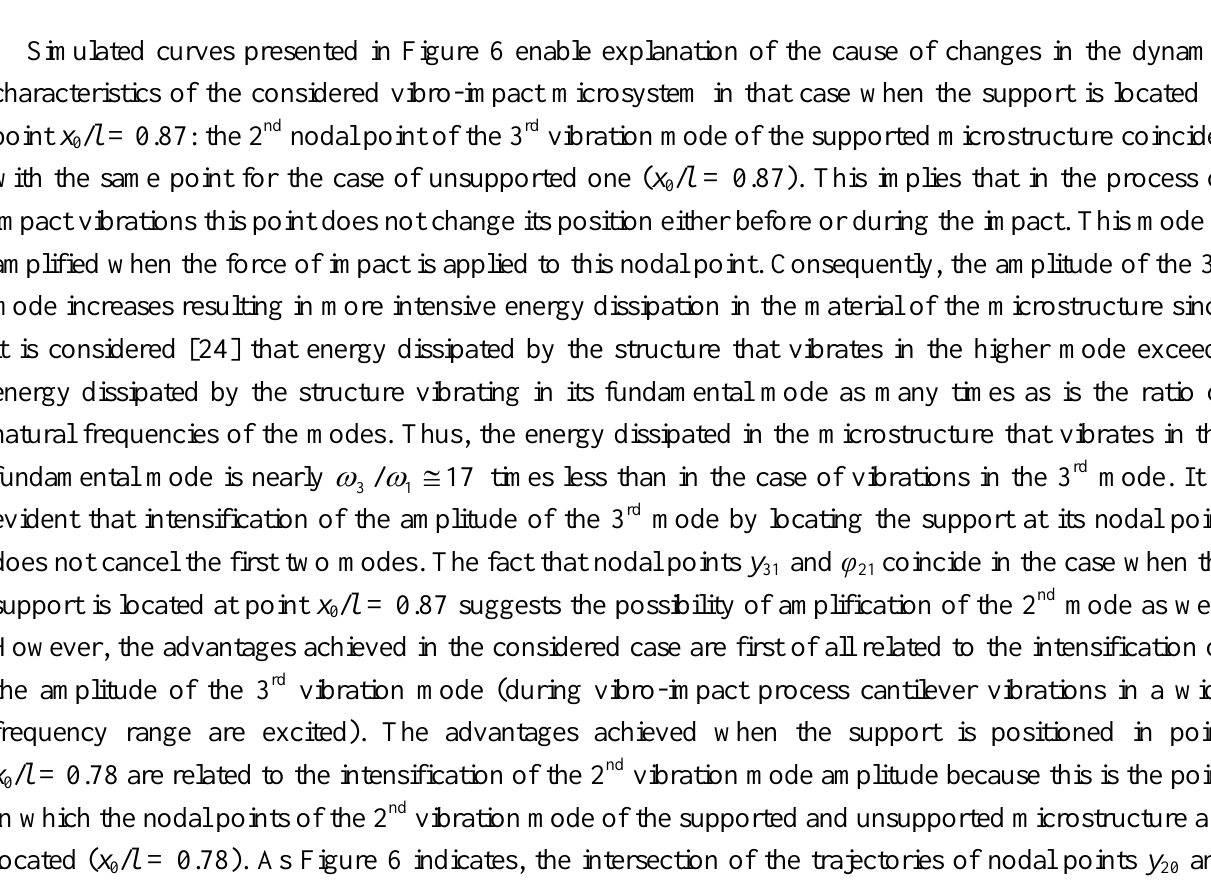
) and rotational (  ) vibration ij ij